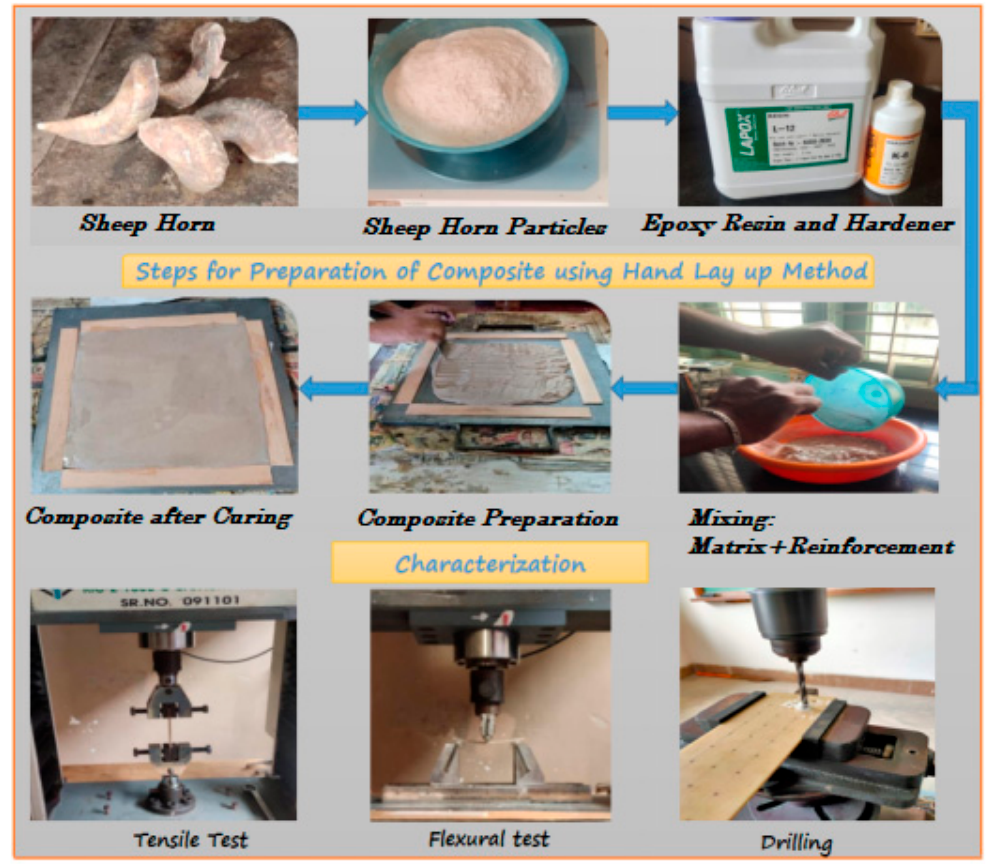
Figure 1. Experimental